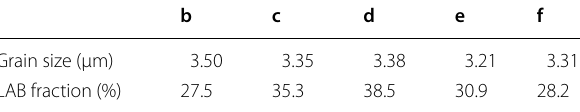
Table 1 Statistic grain size and LAB fraction at the locations in the vortex material flow